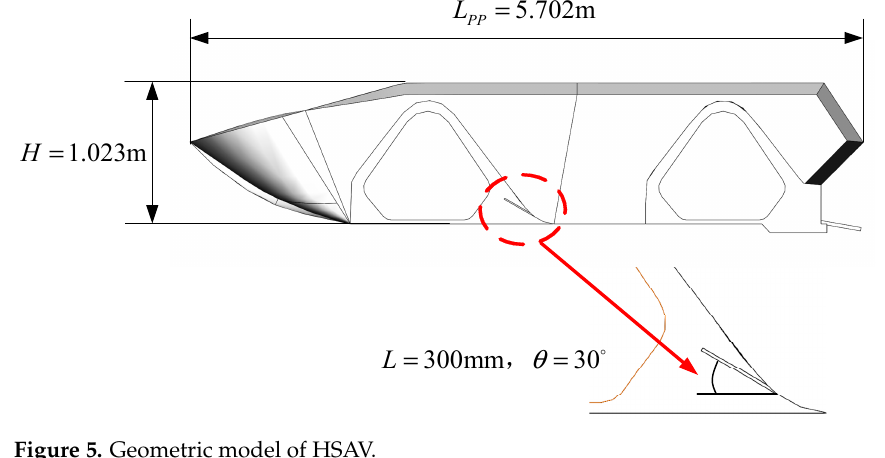
Figure 5. Geometric model of HSAV. Table 1. Main geometric parameters of the vehicle model.